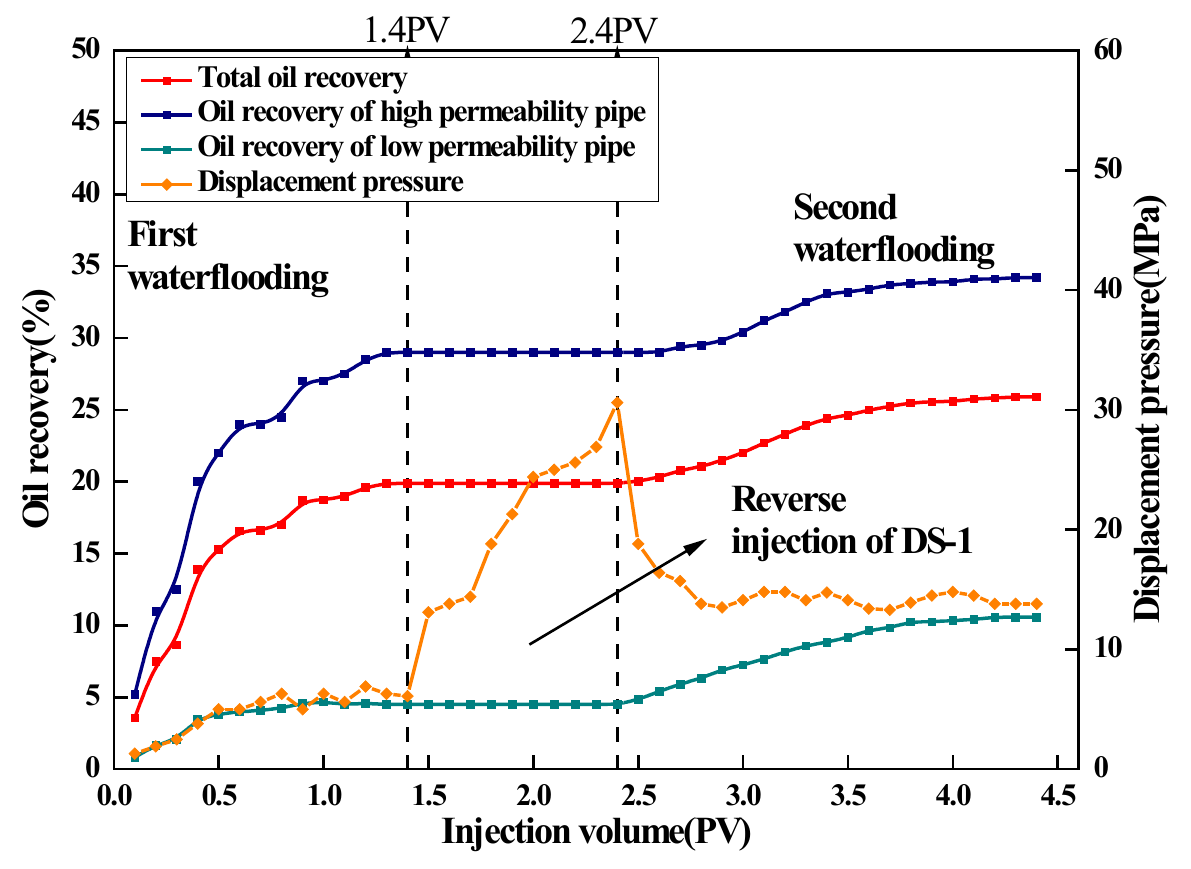
Figure 9. Experiment of enhanced oil